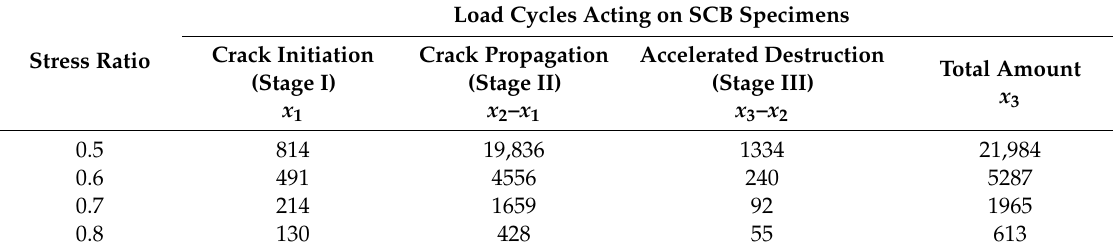
Table 2. Statistics of load cycles in SCB fatigue tests.